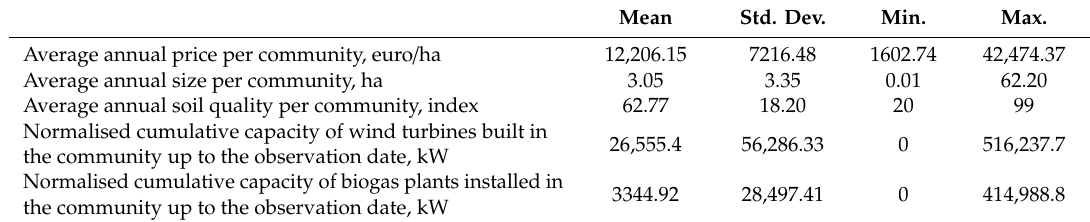
Table 1. Descriptive statistics of determinants of farmland prices in the community-based model, 2007–2016 ( N =